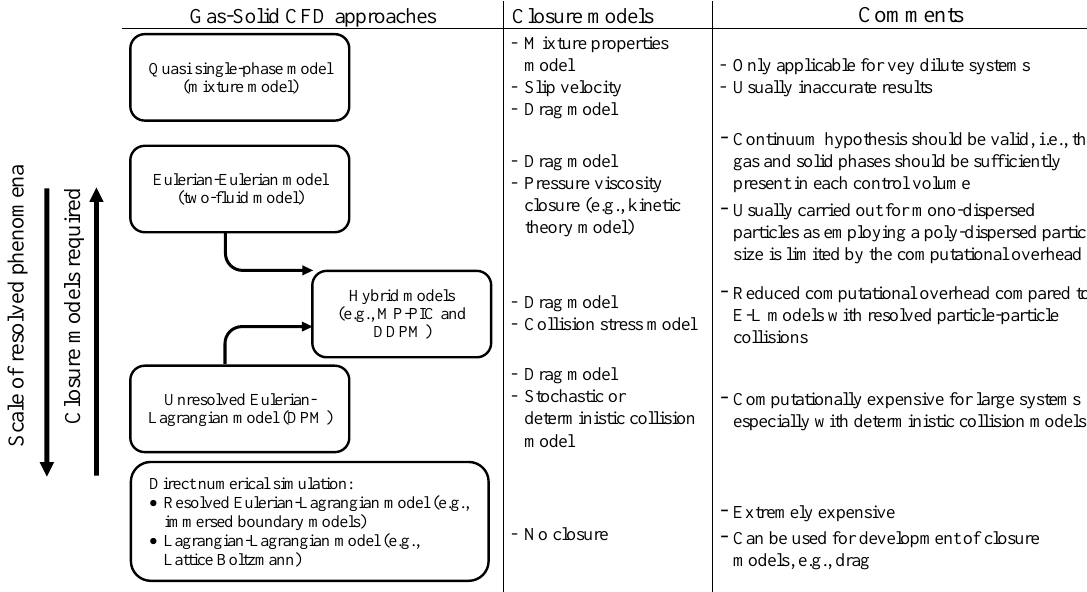
Table 1. Summary of the available approaches for computational fluid dynamics (CFD) simulation of gas–solid flows with the inclusion of closure models to be considered in each approach. The table is inspired from